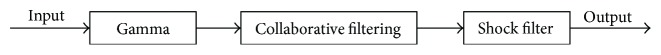
A flowchart of the proposed collaborative shock-filtering algorithm. A noisy OCT image is enhanced through three steps in sequence: gamma manipulation (gamma), collaborative filtering, and shock filter, respectively.